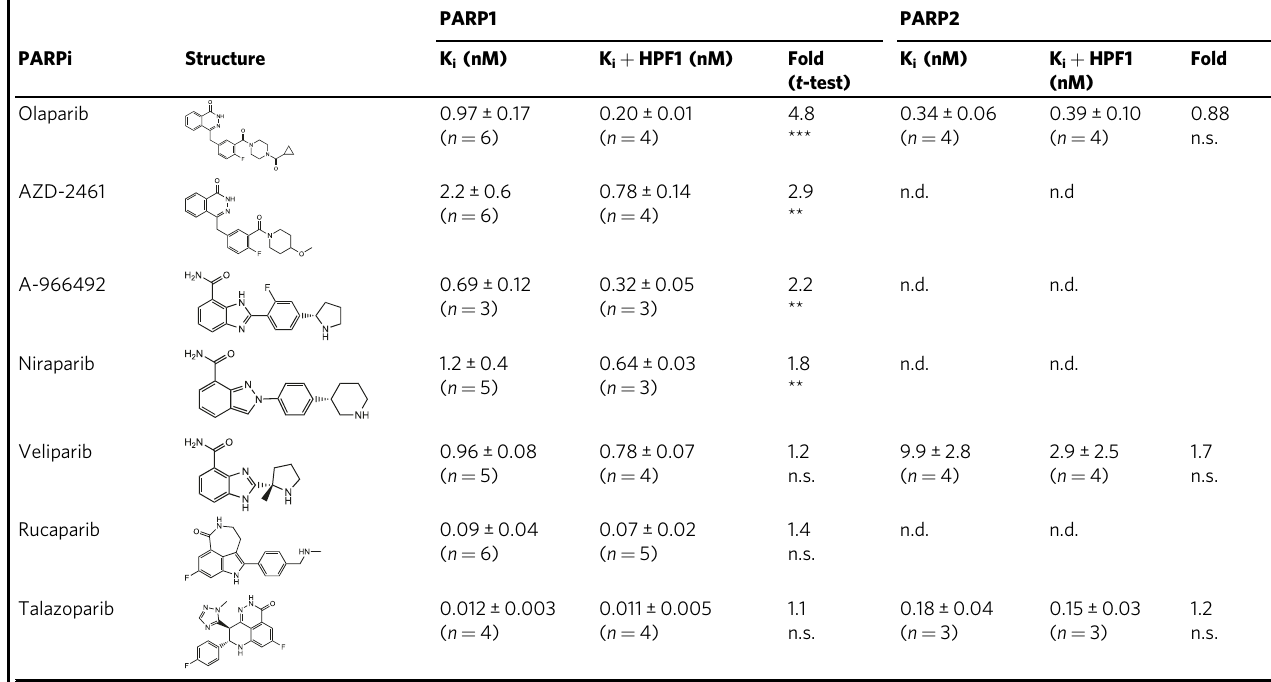
Table 1 K I values (with standard deviations) for PARPi binding to PARP1 and PARP2 alone or in the presence of